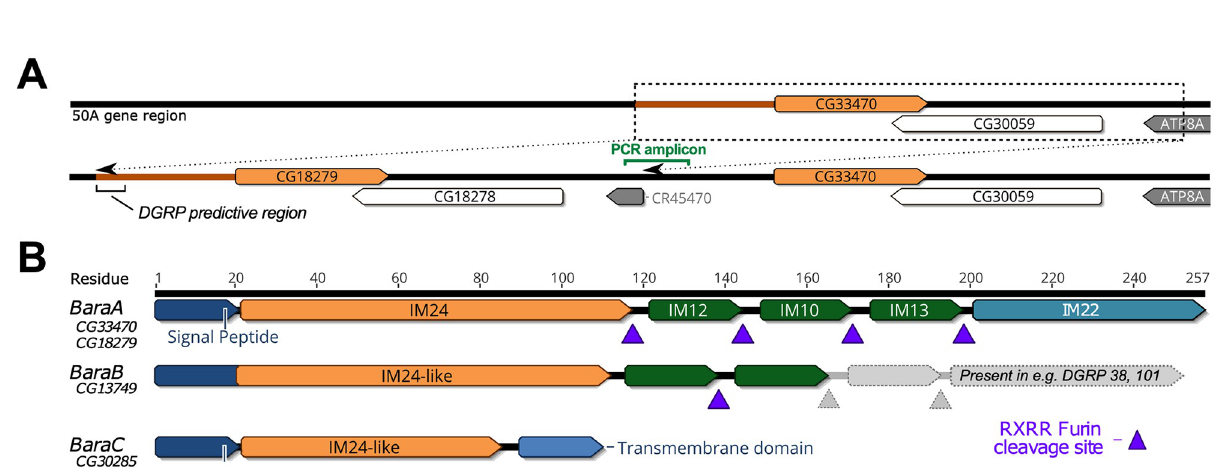
Fig 2. The D . melanogaster Baramicin genes. A) Schematic of the BaraA duplication. Using a PCR assay spanning the duplication-specific locus (PCR amplicon), we confirmed BaraA copy number is variable in various lab strains [21] and wild-caught flies (S1 Data). B) D . melanogaster encodes two other Baramicin genes that we name BaraB and BaraC . These paralogs differ markedly in their precursor protein structure through truncation of the C- terminus relative to BaraA . The BaraB truncation is segregating in the DGRP (greyed out region, and see S2 Data).